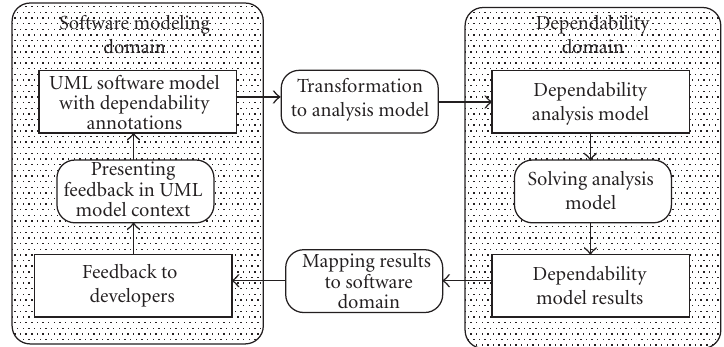
Figure 1: Integrating dependability modeling and analysis in a UML-based software